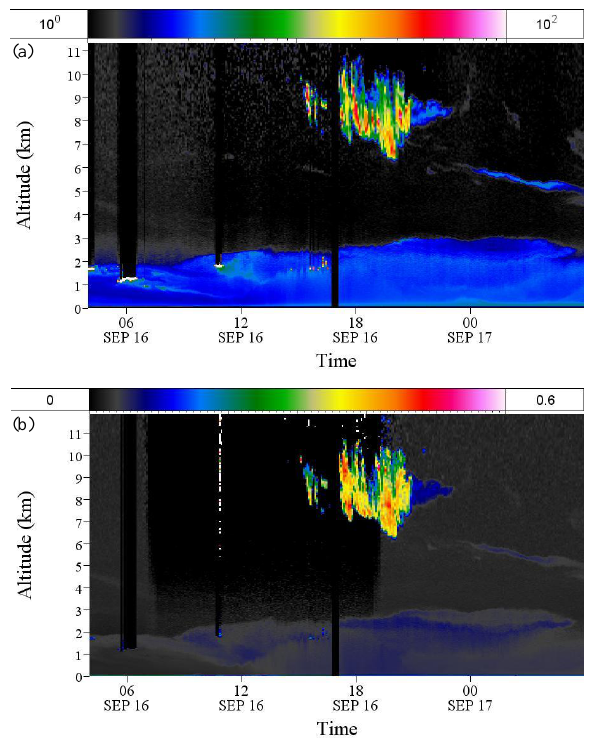
Fig. 7. False colour plot of the (a) lidar backscatter ratio at 532nm and (b) the depolarization ratio at 532nm. The cirrus cloud shows significant depolarization as expected from a cloud primarily com- posed of ice